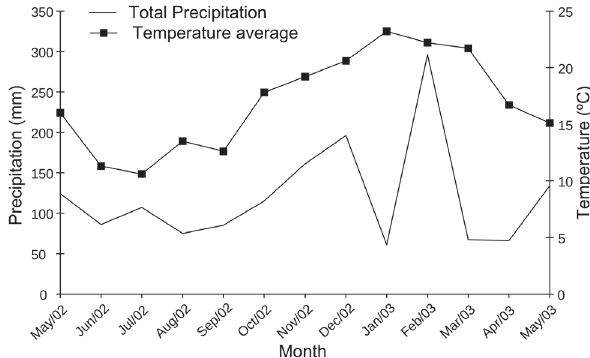
Figure 6. Temperature and rainfall monthly averages during the study period. Source: Dirección Nacional de Meteorología,